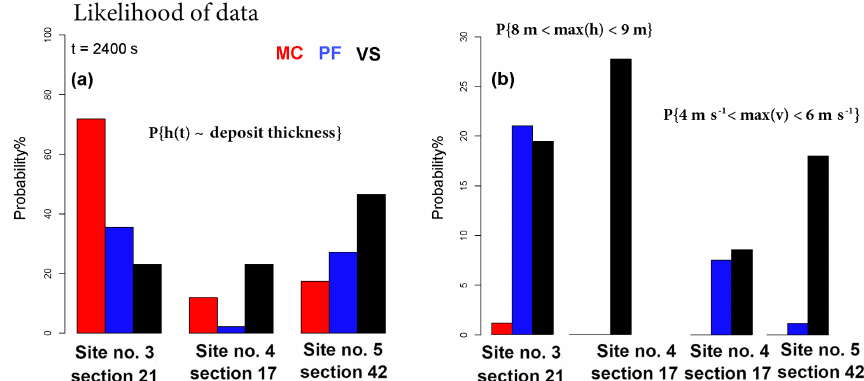
Figure 13. Bar plots of data likelihood in sites 3–5. Panel (a) compares flow height at t = 2400s with observed deposit thickness (Saucedo et al., 2008). Panel (b) compares maximum height and maximum speed with observed wave height (Ponce-Segura, 1983) and the peak flow speed obtained using the methods of Pierson (1985). Different models are displayed with different